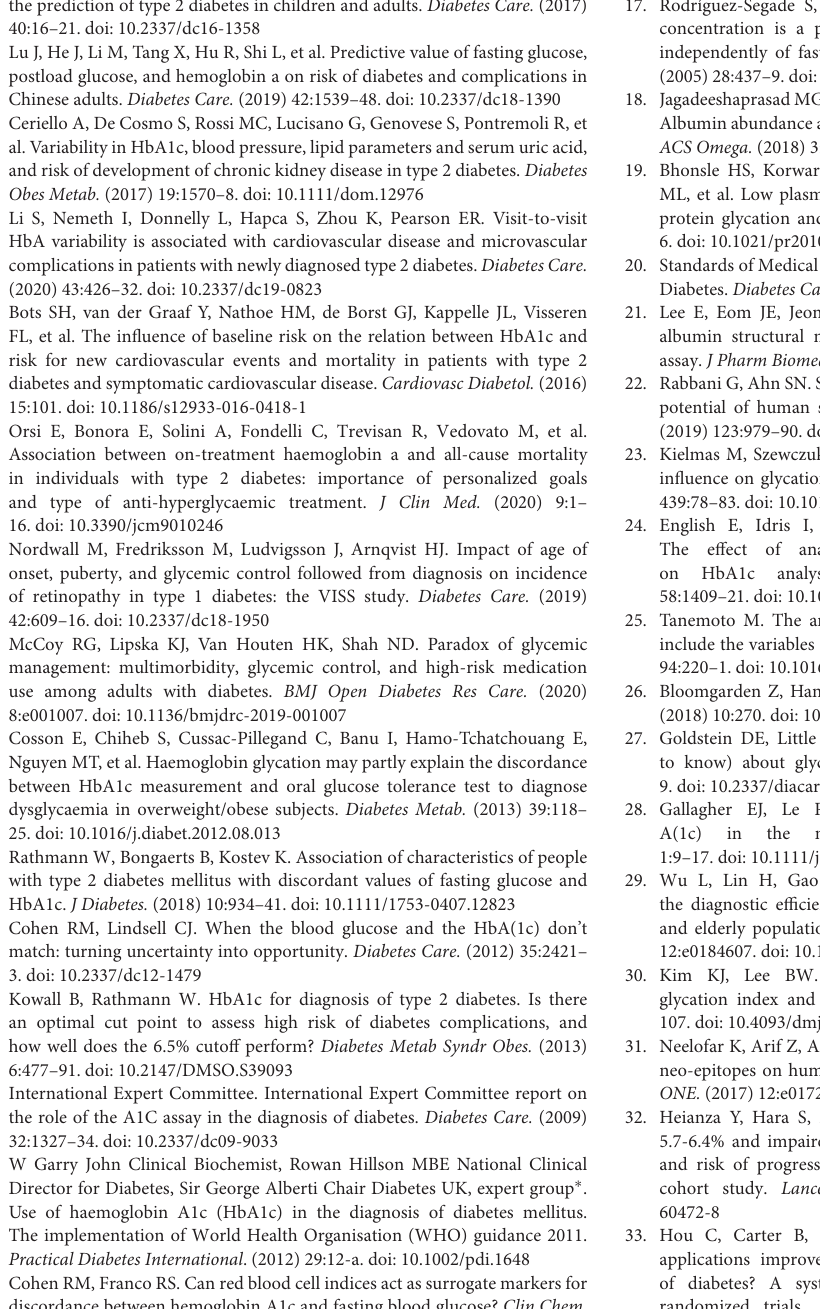
Supplementary Table 1 | Univariate analysis of characteristics of the participants with